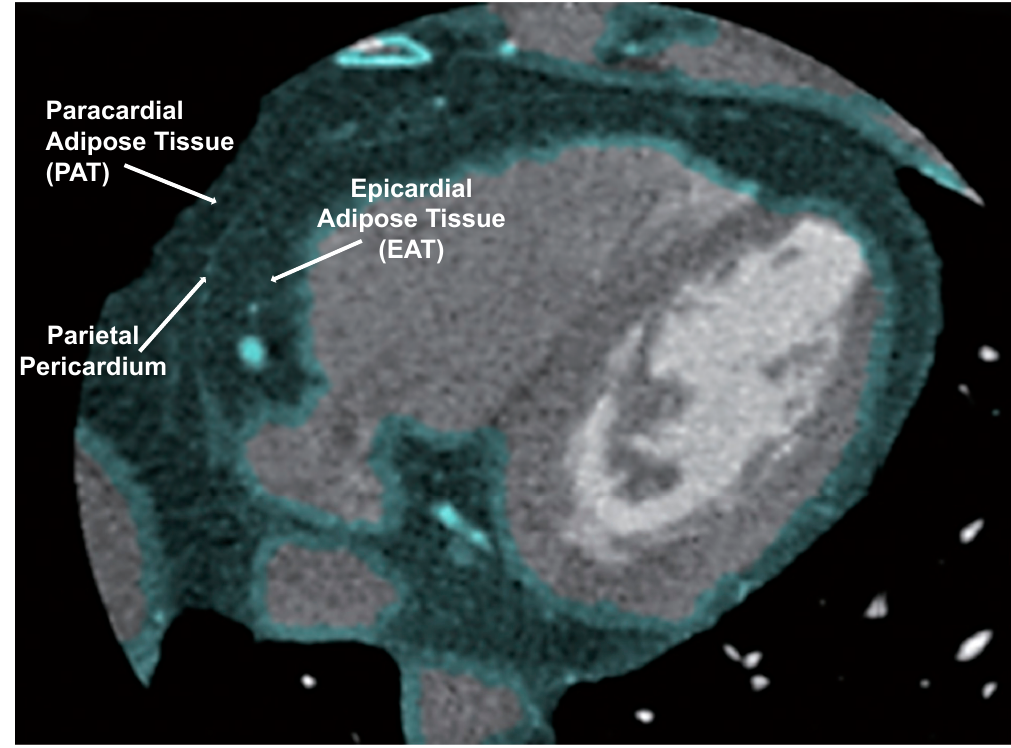
Figure 8. Figures show proximity of Pericardial fat adipose tissue to the heart. Figure also identifies paracardial adipose tissue. Paracardial adipose tissue includes both Pericardial fat and Paracardial adipose